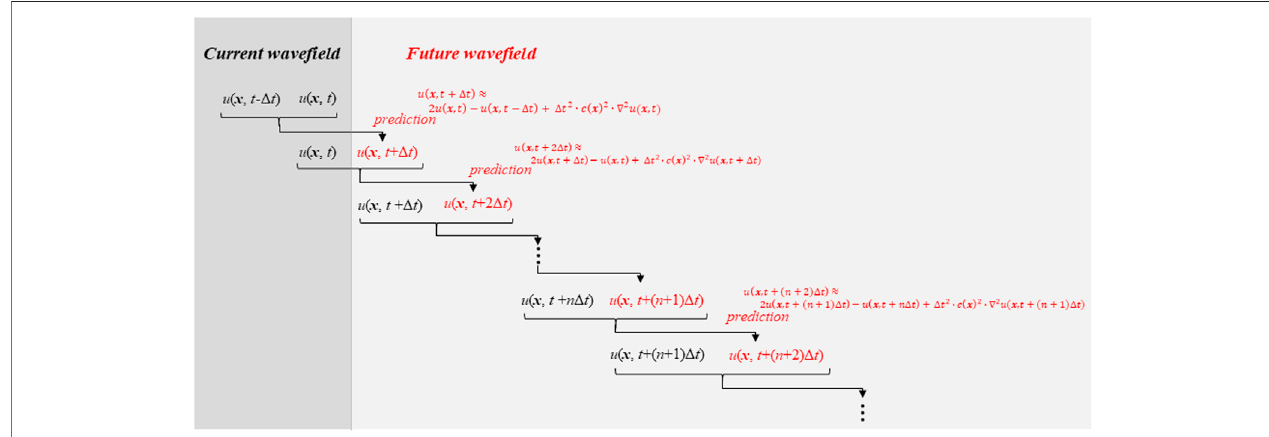
FIGURE1| Theprocessforpredictingfuturewave fi eldusingthe fi nitedifferencemethod.Fromthecurrentwave fi eld, u ( x , t- Δ t )and u ( x , t ),thefuturewave fi eld, u ( x , t+ Δ t ),ispredicted,andthen,from u ( x , t )and u ( x , t+ Δ t ), u ( x , t+ 2 Δ t )isforecast.Repeatingthisprocessmakesitpossibletoobtainthewave fi eldsatanytimeinthefuture.